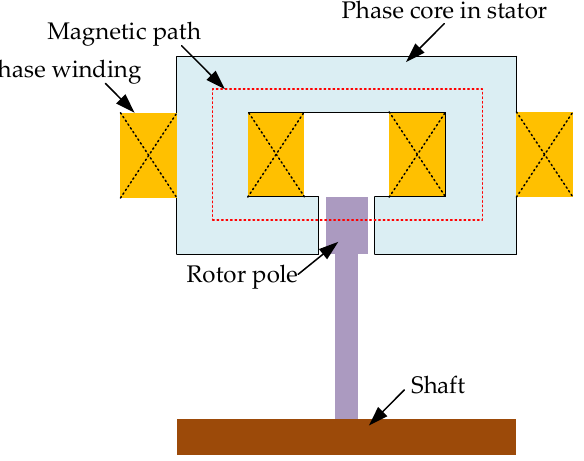
Figure 13. Comprehensive segmented yokeless rotor SRM [35].